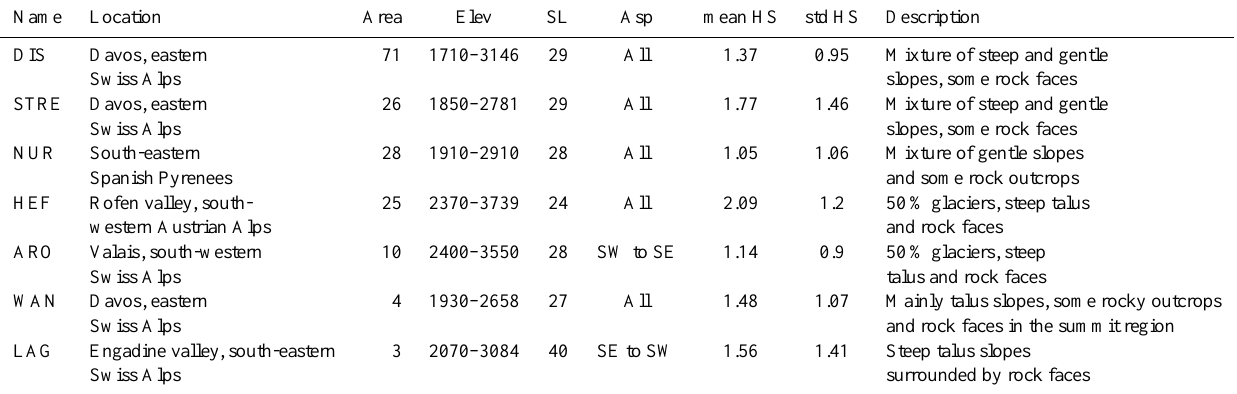
Table 2. Summary statistics and main characteristics of the investigation areas: “Area” is given in km 2 , elevation range (EL) in ma.s.l., mean slope (SL) in ◦ , mean and standard deviation (SD) of snow depth (HS) in m. Areas with trees and larger vegetation were masked from the data